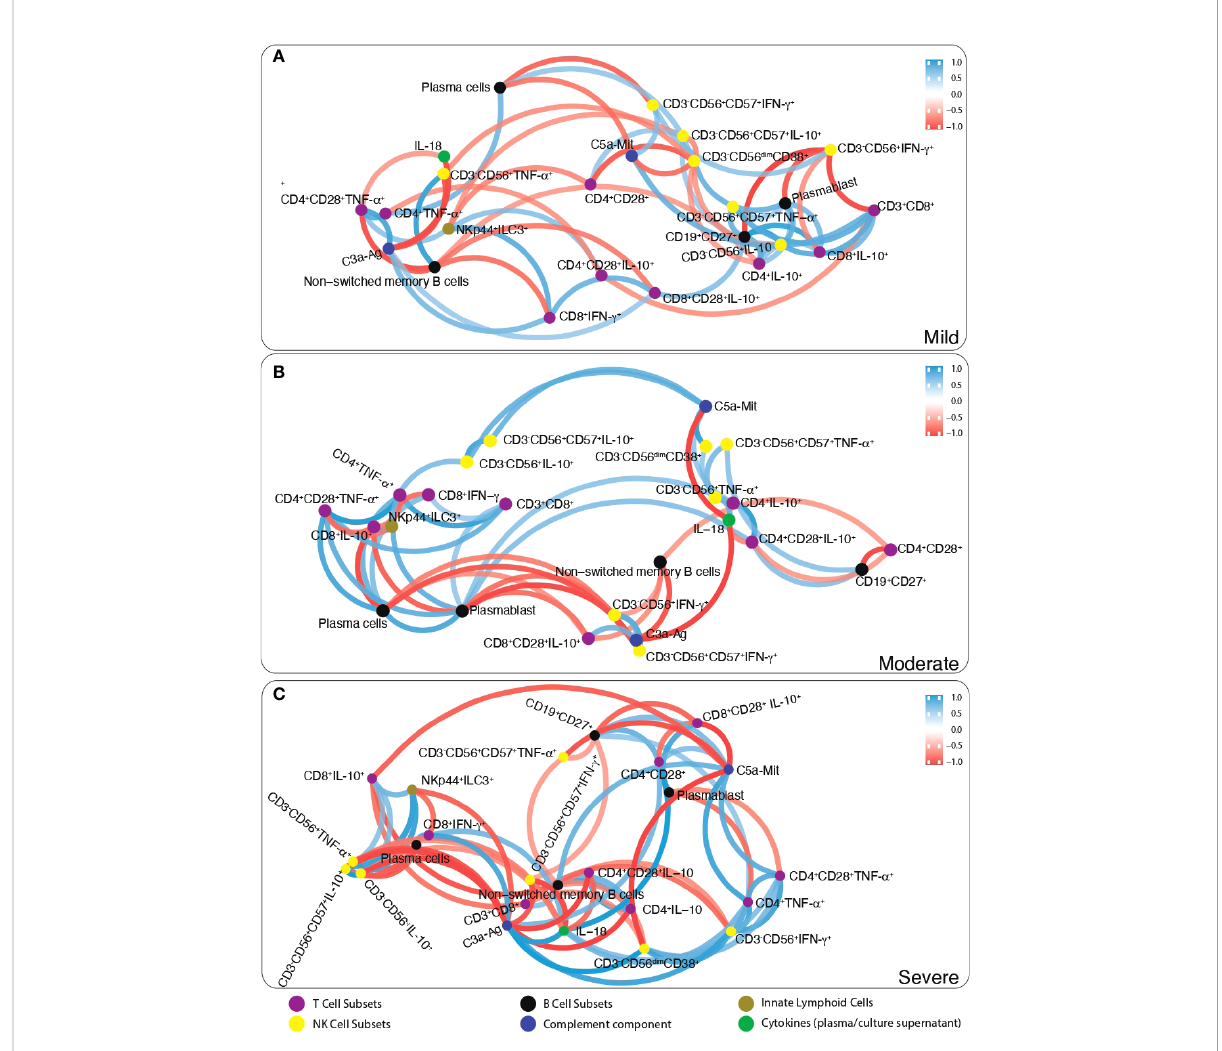
FIGURE 6 The network analysis of immune parameters in COVID-19 patients. Correlation network plot of ILCs, NK cells, T and B lymphocytes, complement components and cytokines levels of (A) mild, (B) moderate and (C) severe patients. Blue lines between parameters indicate positive correlations whereas red lines indicate negative correlations. The signi fi cance of correlations increases in proportion with increased boldness of line